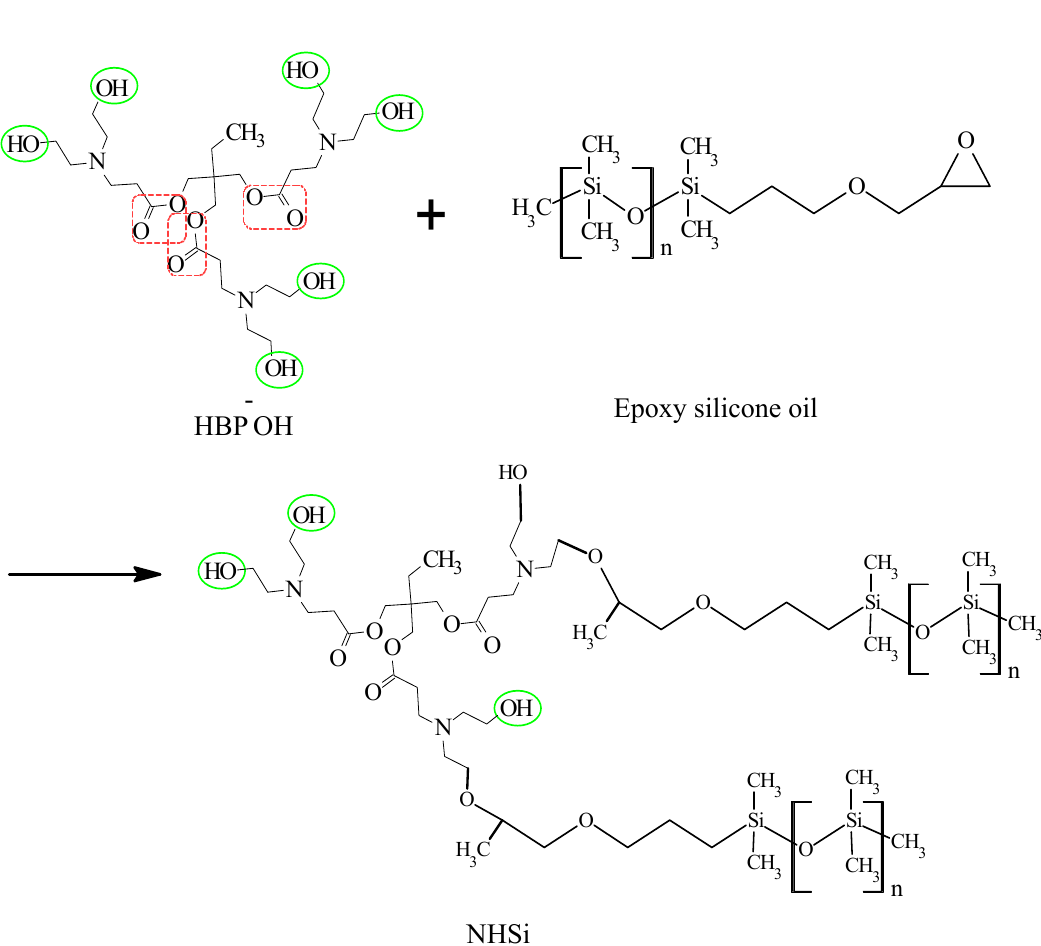
Figure 1. The synthesis route of NHSi.